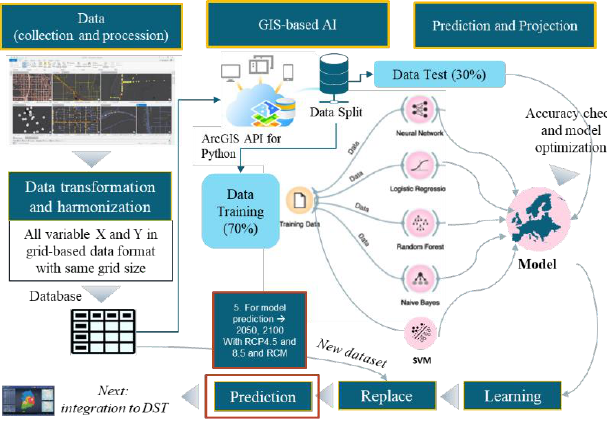
Figure 8. ML model of coastal flood risk assessment Coastal flooding is driven by stochastic high-water events, such penetrating onto land (Lorie et al., 2020). Some coastal flood parameters are used in the analysis, as shown in Figure 9 and listed below.